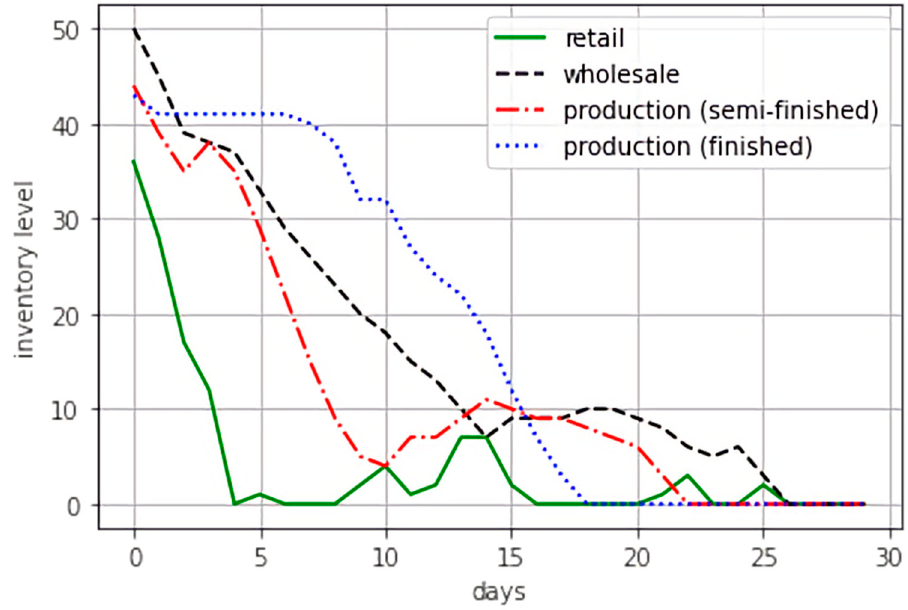
Figure 7. Unusual inventory dynamics under the control of the PPO agent during the third experi- ment.